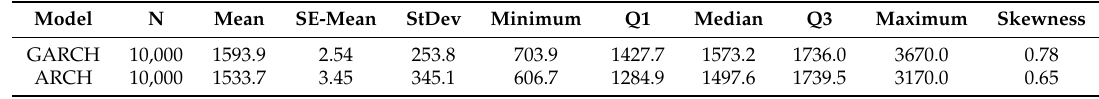
Table 5. Terminal distribution